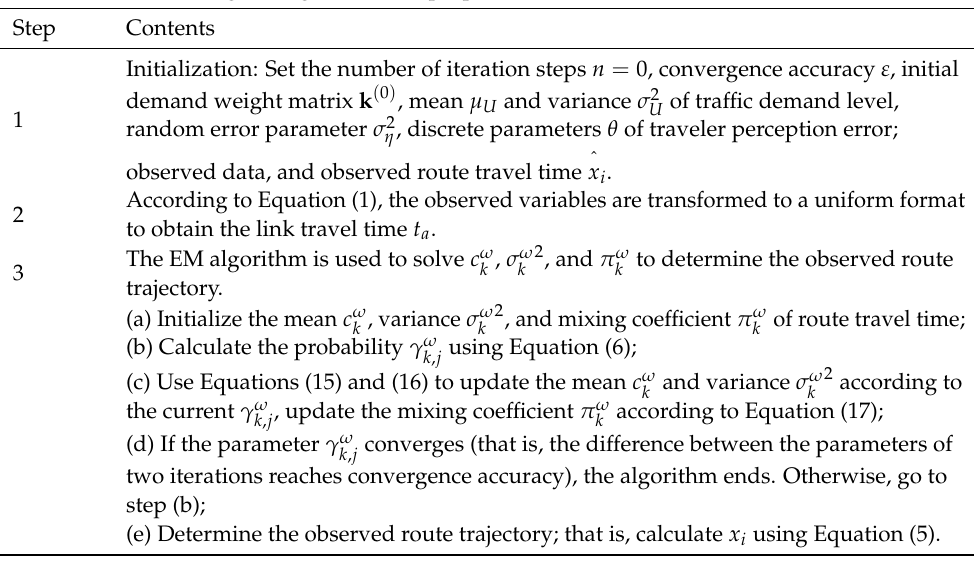
Algorithm 1 The designed algorithms for proposed